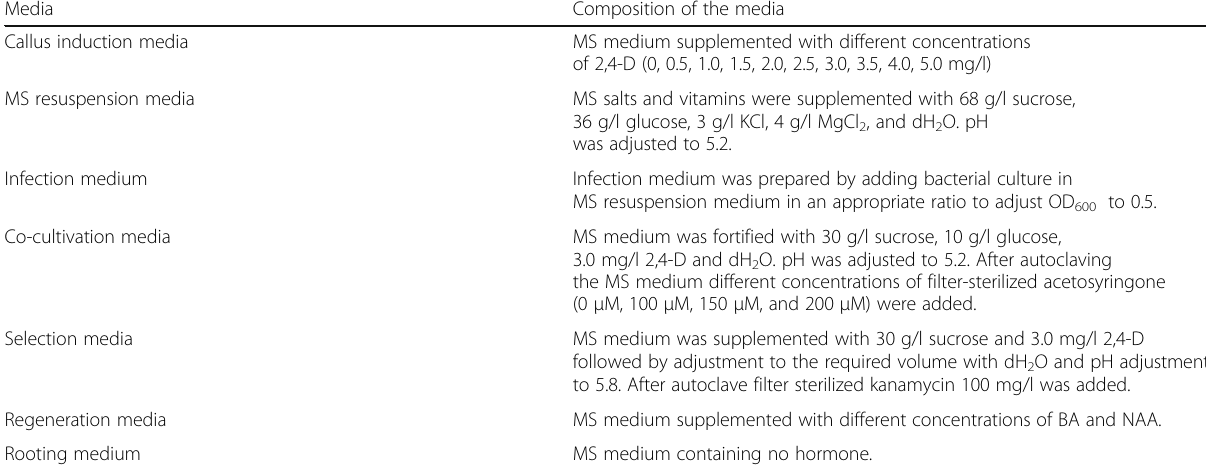
Table 1 The composition of different media used in this transformation study Media Composition of the